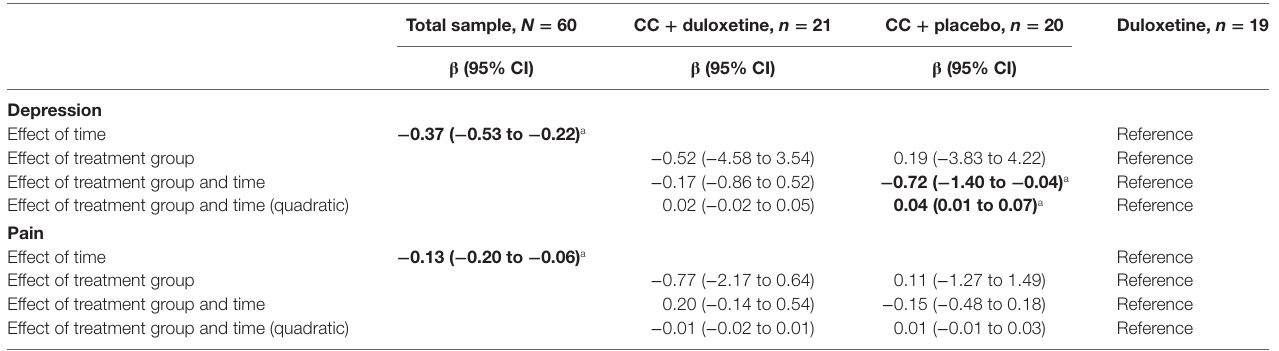
TaBlE 4 | Explorative, per protocol, multilevel analyses comparing the CC + duloxetine, and CC + placebo treatment groups with the duloxetine alone treatment group for depressive and pain symptoms for patients who were